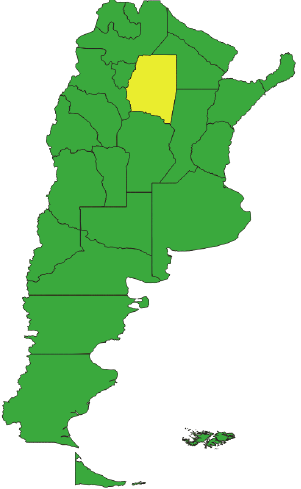
Figure 2: Geographical location of Santiago del Estero Province,